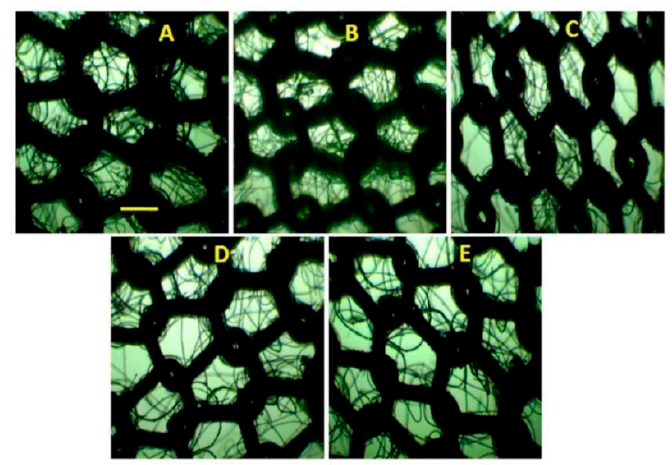
Figure 3. Effect of washing and drying cycles on the fabric porosity. ( A ) bright field microscopic images of unwashed CM9, and after ( B ) first, ( C ) second, ( D ) third, and ( E ) fourth washing and drying cycles [54].